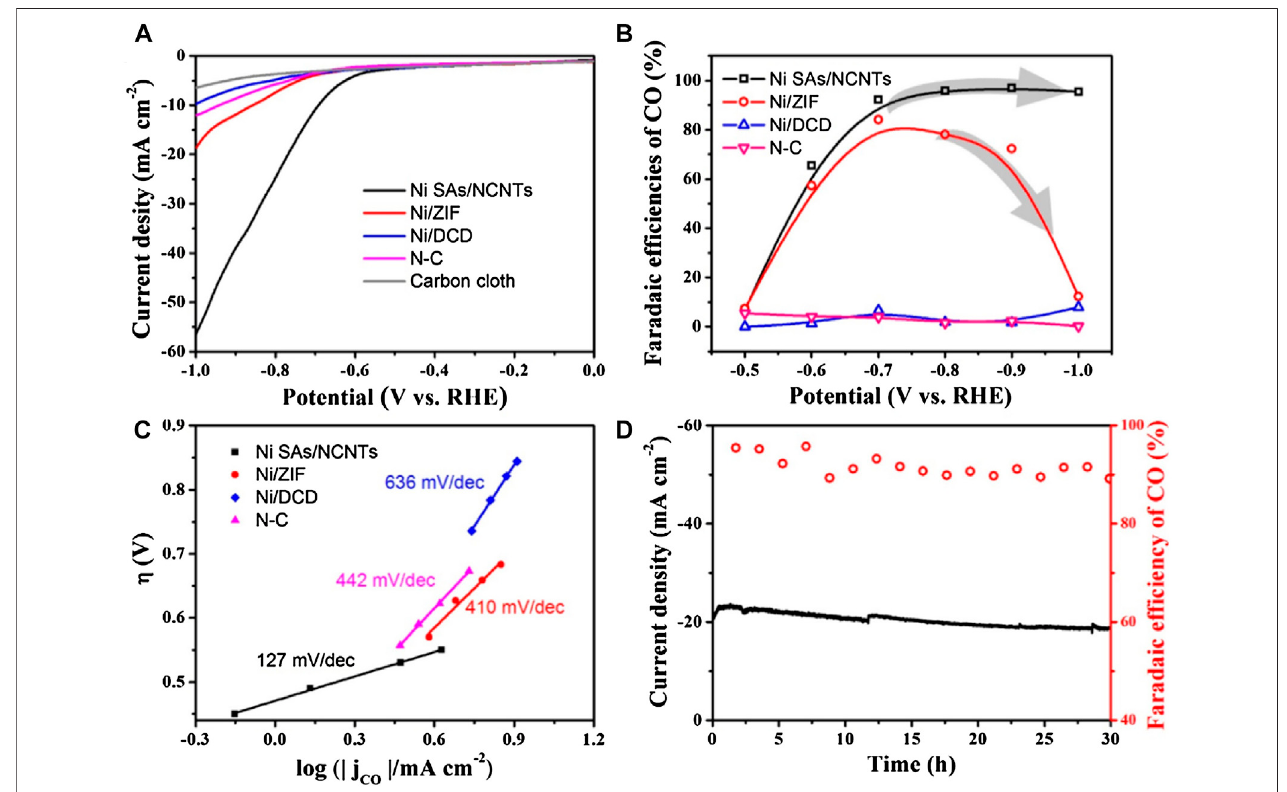
FIGURE6|(A) Linearsweepvoltammetriccurves,andpurecarbon clothservers asbackground. (B) Faradaicef fi cienciesofCOatdifferentappliedpotentials. (C) Tafel plots for producing CO. (D) Catalytic stability test of Ni SAs/NCNTs at − 0.75 V for 30 h (Lu et al., 2019). Copyright 2019, Elsevier.